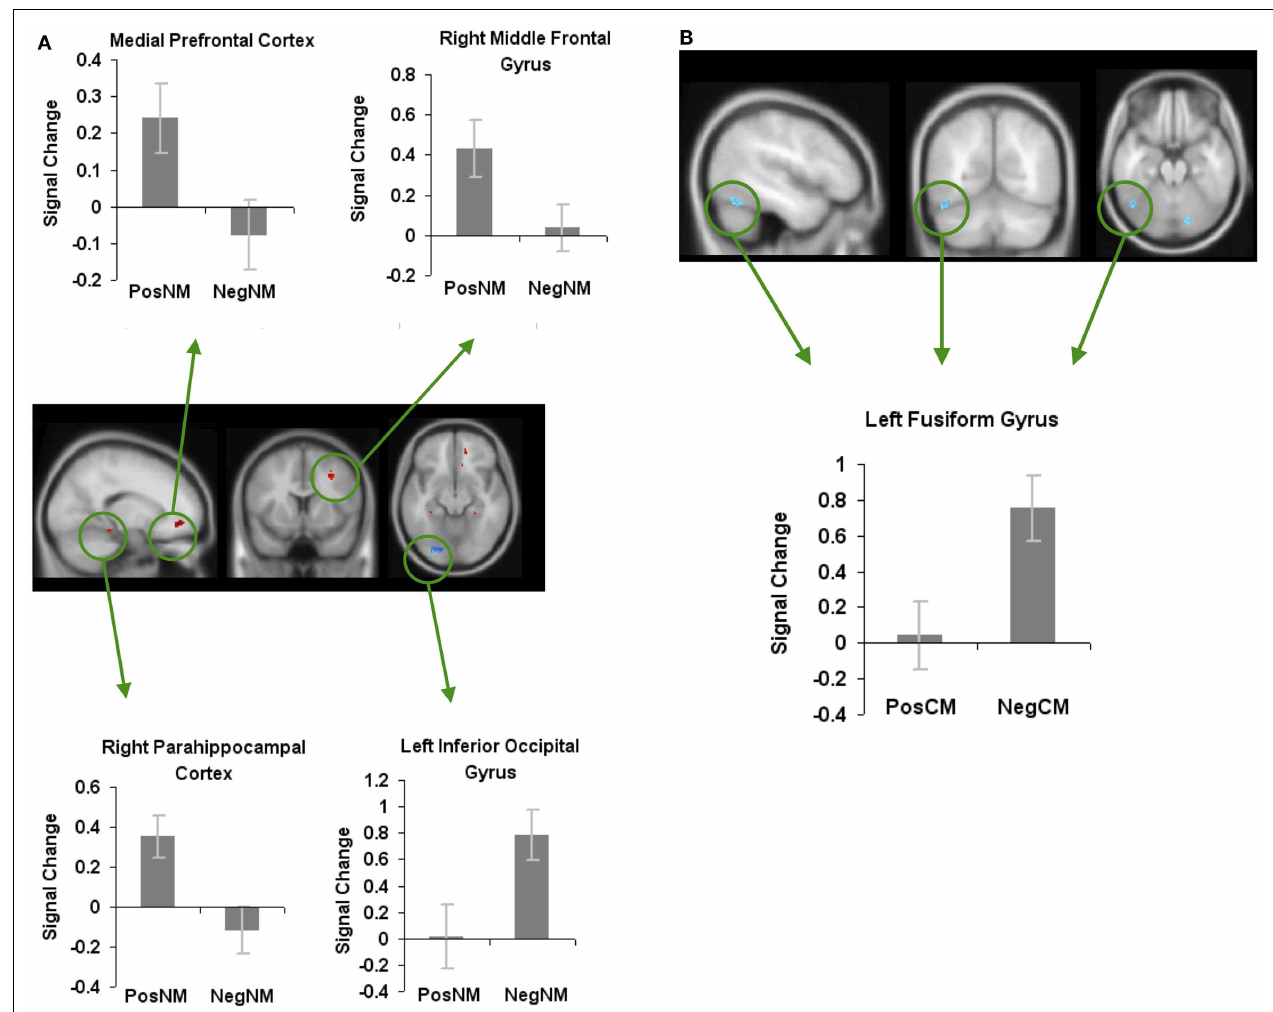
FIGURE 6 |Whole-brain activation showing signal change for the positively valenced versus negatively valenced metaphoric type-specific contrasts (A) reveals signal change for positively valenced novel metaphors versus negatively valenced novel metaphors (B) reveals signal change for positively valenced conventional metaphors versus